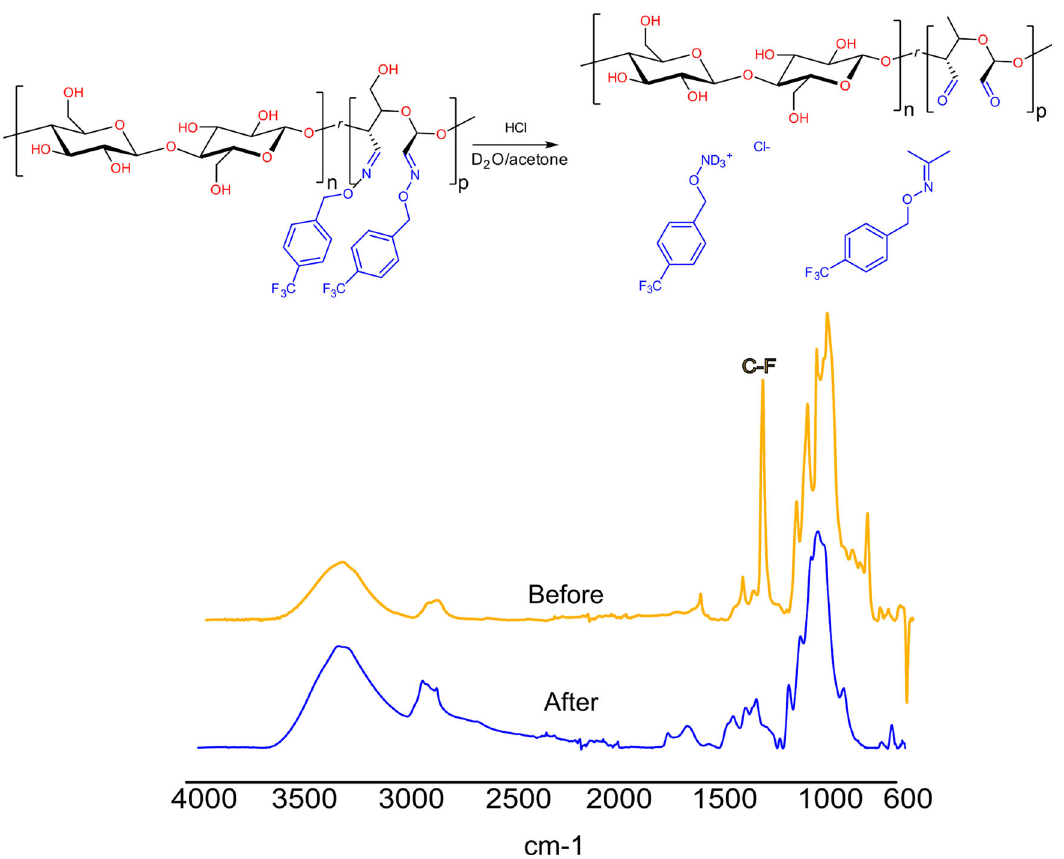
Fig. 5 | Defunctionalization of R-ON-CNF. Slow release of the functional group (CF 3 Bn) from the CF 3 Bn-ON-CNF in 1M HCl solution in acetone/water (1/1, v/v) at